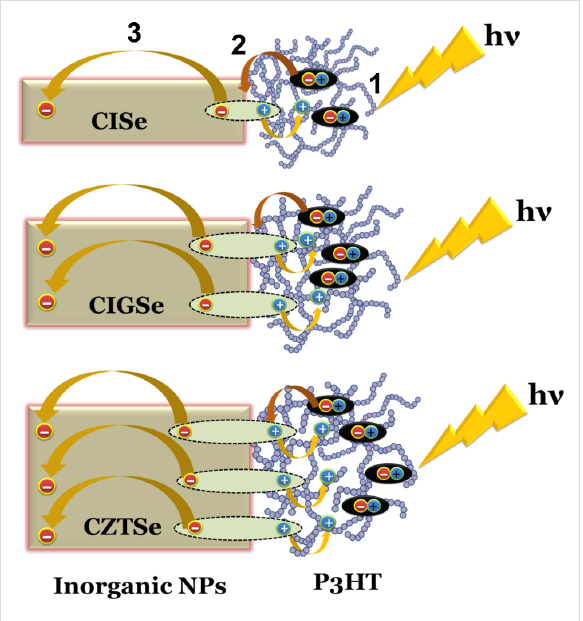
Figure 11: Schematic of the charge generation and separation mecha- nism. Generation of excitons (1), charge separation (2) and current generation (3) for (a) P3HT:CISe, (b) P3HT:CIGSe and (c) P3HT:CZTSe